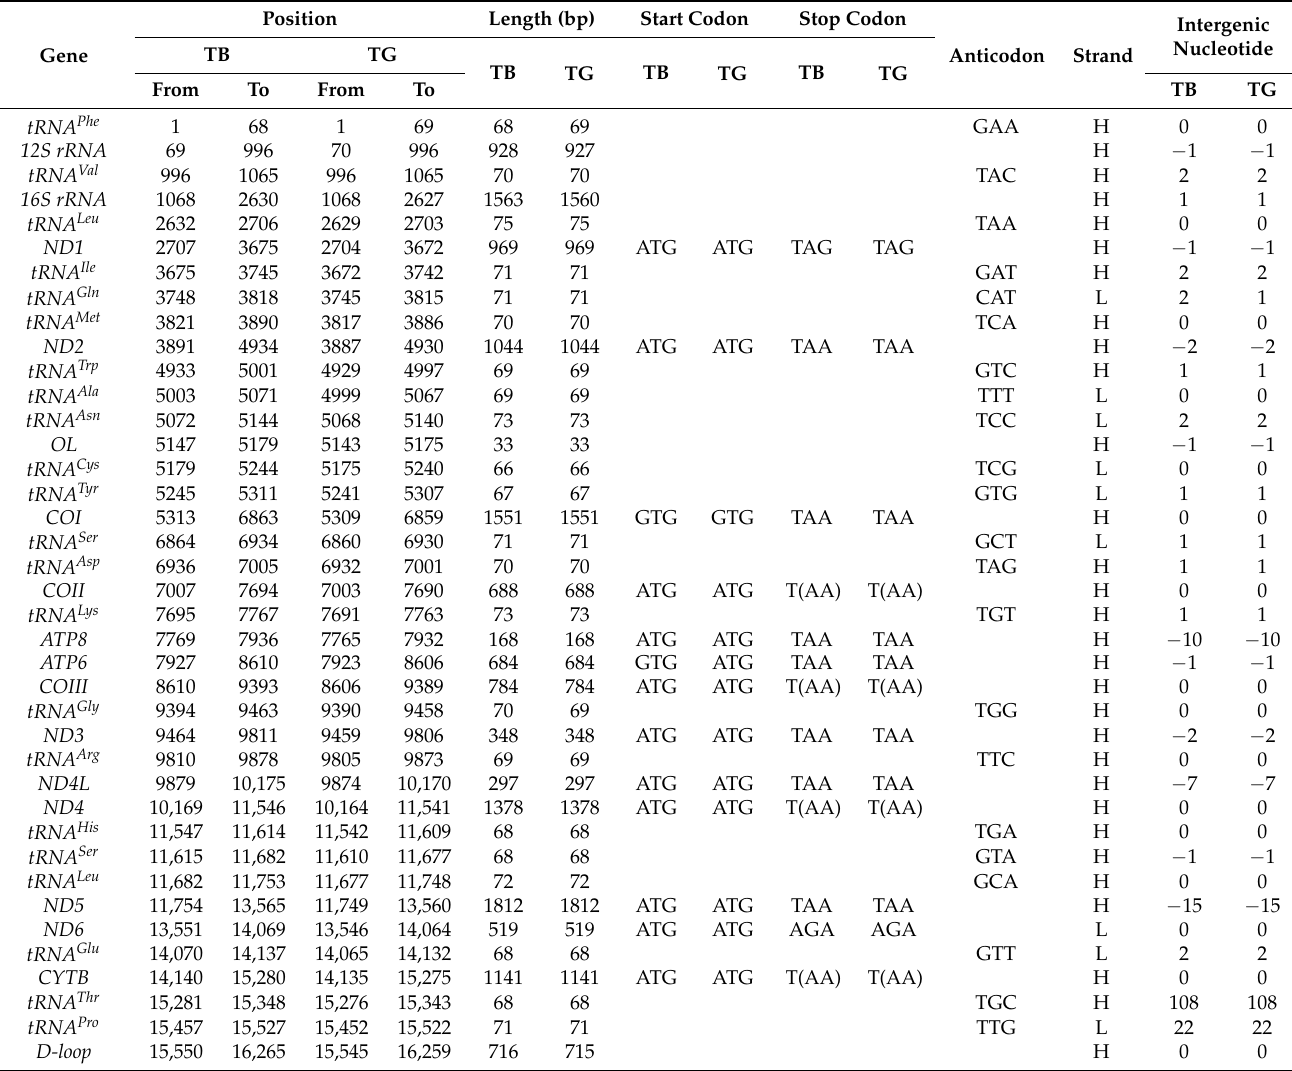
Table 1. Mitochondrial genome organization of T. broadoridgus (TB) and T. gaowangjienensis